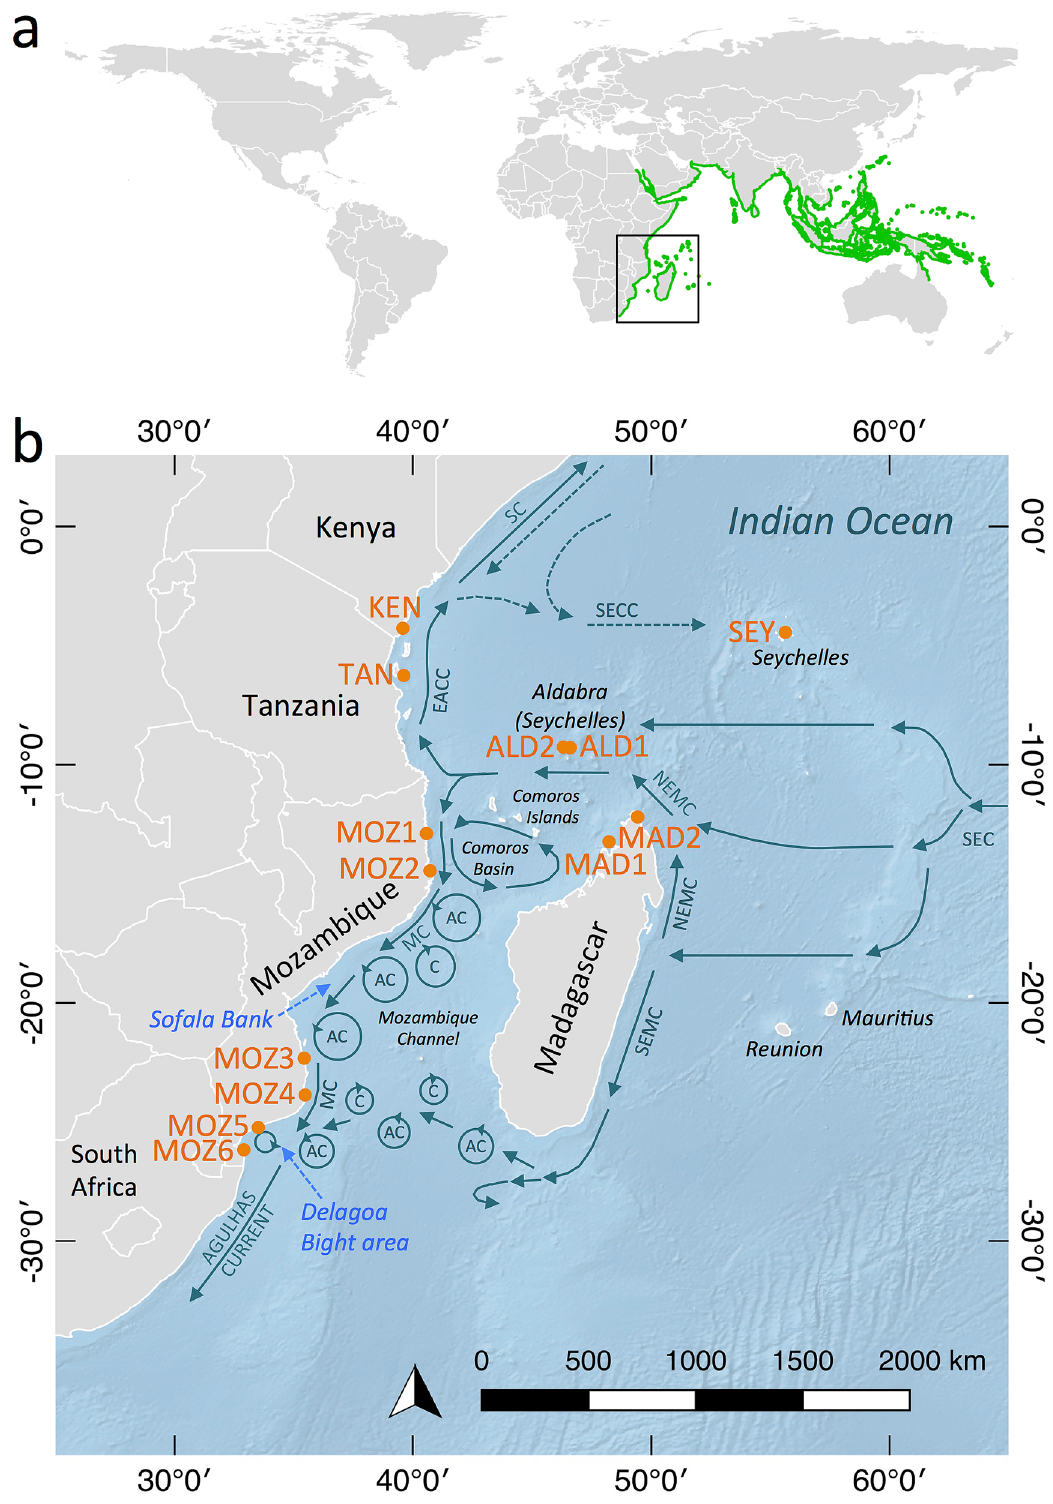
Figure 1. Global distribution of Rhizophora mucronata and the dominant ocean circulation in the Western Indian Ocean region where 13 populations were sampled. ( a ) Global distribution of R. mucronata 36 (green) and the study region (black rectangle). ( b ) Schematic representation of the dominant near-surface circulation in the Western Indian Ocean region 51 . North-East and South-East Madagascar Currents (NEMC, SEMC); Mozambique Current (MC), highly irregular in its occurrence 83 ; Anti-cyclonic eddies (AC); Cyclonic eddies (C); East Africa Coastal Current (EACC); and the Somali Current (SC) and South Equatorial Current (SEC), during the northeast monsoon (November-February, dotted line) and the southwest (June–September) monsoon season 41 ; and the South Equatorial Countercurrent (SECC). Sampled populations of R. mucronata are shown in orange. Population codes are denoted in Table 1. The background map was created with the QGIS 3.10.10 software (www.qgis.org), using detailed (1:10 m) ocean bottom relief, land and island polygons, as well as country administrative boundaries provided by Natural Earth (www.natur alear thdat